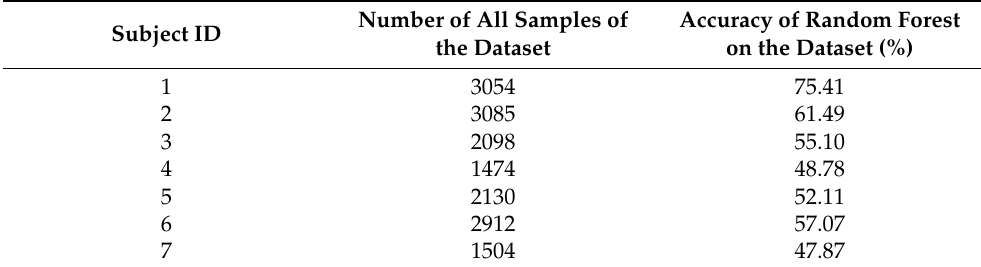
Table 3. Subject ID, number of samples, and accuracy of the random forest for datasets with samples from one